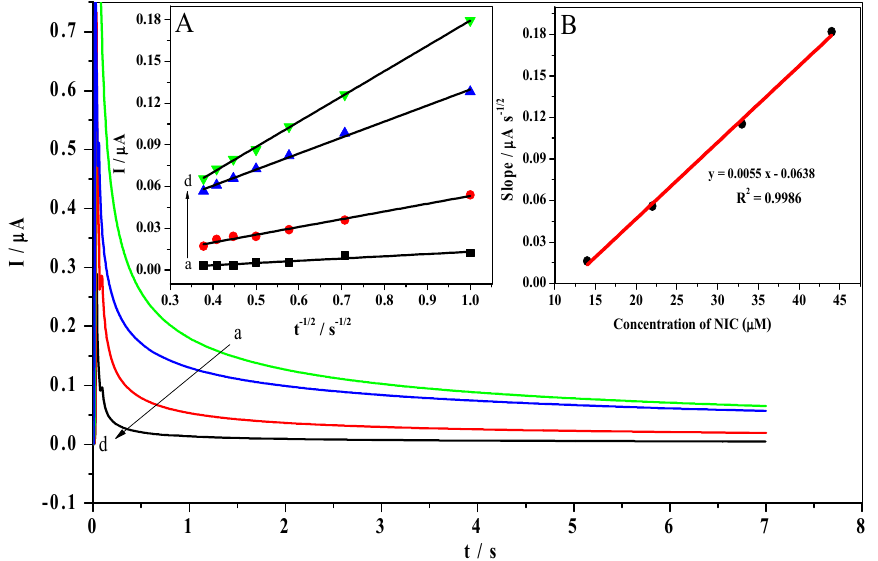
Figure 12. Chronoamperograms were obtained at the GO/Nq/GCE in 0.1 M of Na 2 SO 4 (pH 8.0) for different concentrations of NIC (a to d: 14, 22, 33, and 44 µ M). Insets: ( A ) a plot of I vs. t − 1/2 , the ( B ) plot of the slope of straight lines vs. NIC concentration.